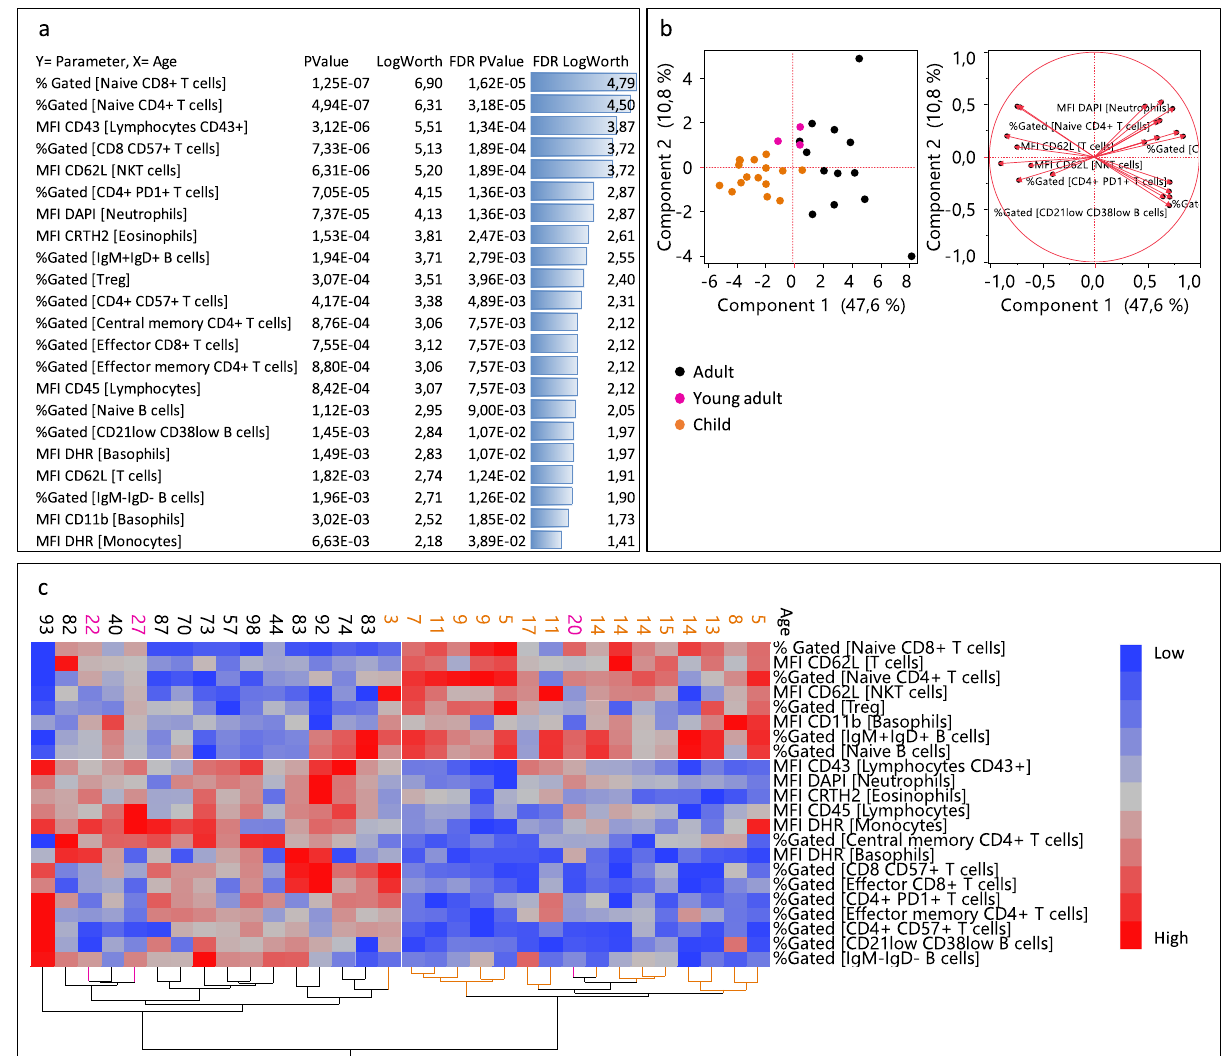
Figure 1. Unsupervised analysis of the biological parameters considered: ( a ) response screen of the features as the function of the age showing the most discriminant factors. ( b ) PCA analysis of the best discriminators. ( c ) Hierarchical clustering of the best factors. Orange dots represent children, black adults, and pink young adults. Parameters in blue are downregulated and parameters in red are